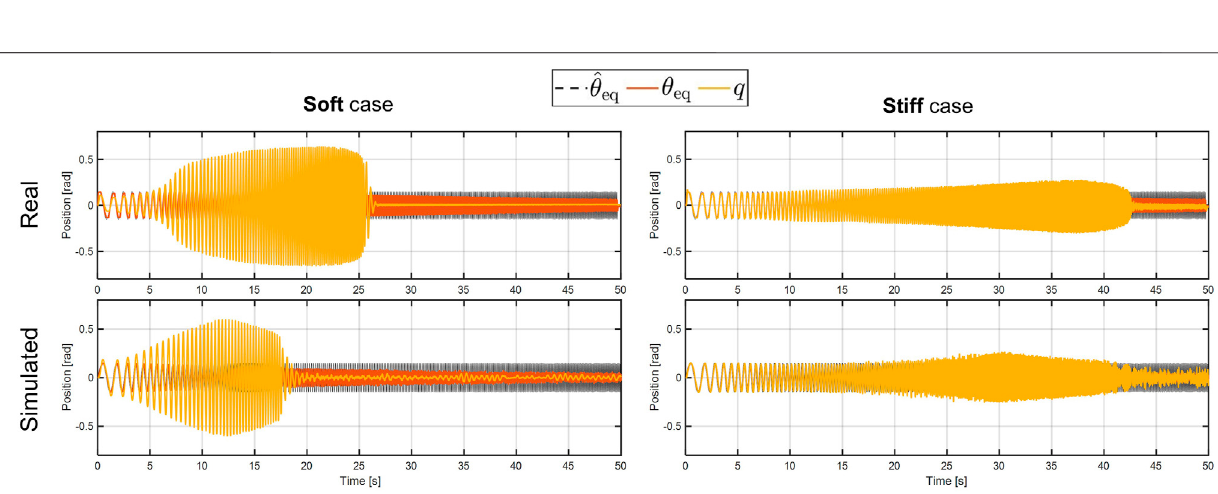
Frontiers in Robotics and AI |